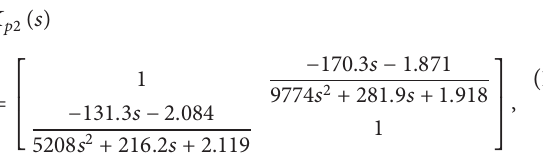
If the parameters 𝛿 1 , 𝛿 2 ∈ (0, 1) , which depend on the positions of the system valves, are set to 𝛿 1 = 0.6 and = 0.41 , this yields a system for which the eigenvalues of 𝛿 2 (𝑗𝜔)+𝐺 ∗ (𝑗𝜔)] show that the quadruple tank is nonpassive [𝐺 2 2 (Figure 3).